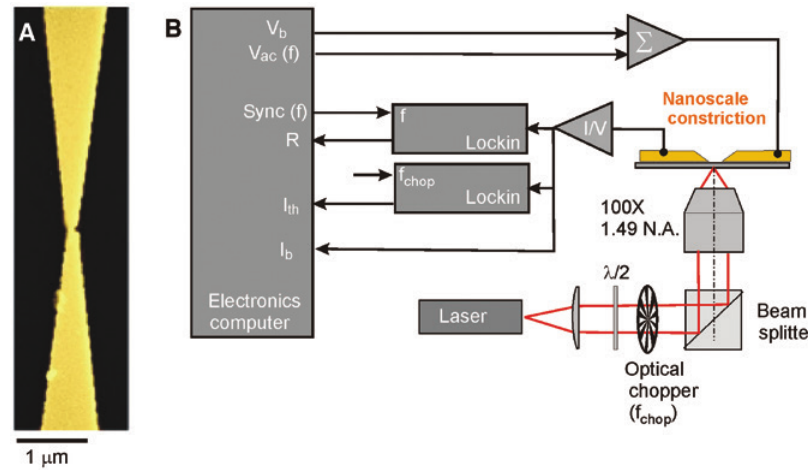
Figure 1: Gold constriction and experimental setup. (A) Colored SEM image of a typical nanoscale Au constriction fabricated on a glass substrate. The narrowest width is 100 nm and the yellow hue corresponds to the Au material. (B) Schematic representation of the setup used for optical excitation and electrical addressing. The total voltage applied to the constriction is the addition of a static bias V and a 20 mV sinusoidal voltage V oscillating at the frequency b ac = 831 Hz. A lock-in detection extracts the different frequency contributions to the total f = 12.6 kHz. The laser is periodically chopped at f chop current measured by a current-to-voltage converter